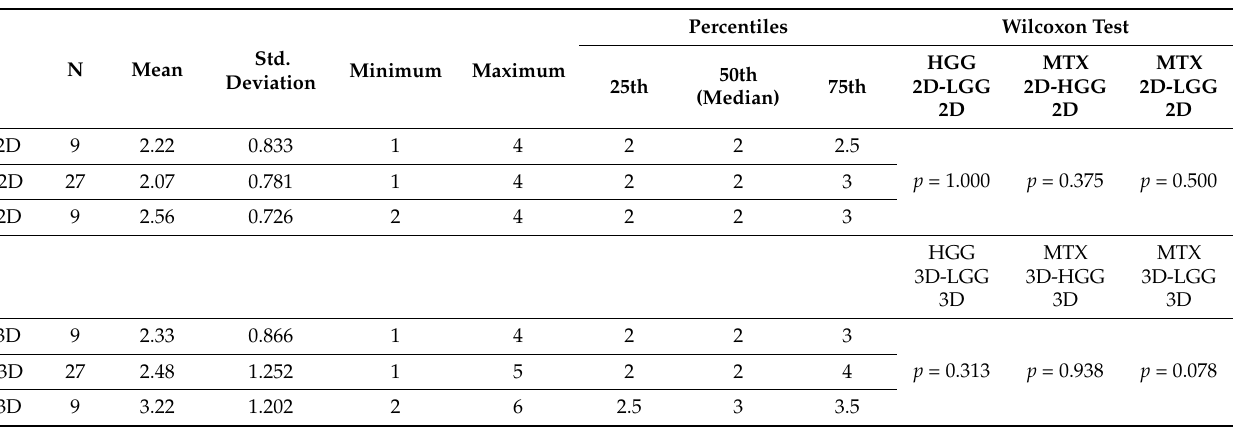
Table A2. Descriptive statistics of 2D and 3D iUS benefit for the three main categories of tumors, with Wilcoxon Signed Ranks Test results; HGG = high-grade gliomas, LGG = low-grade gliomas, MTX = metastases.